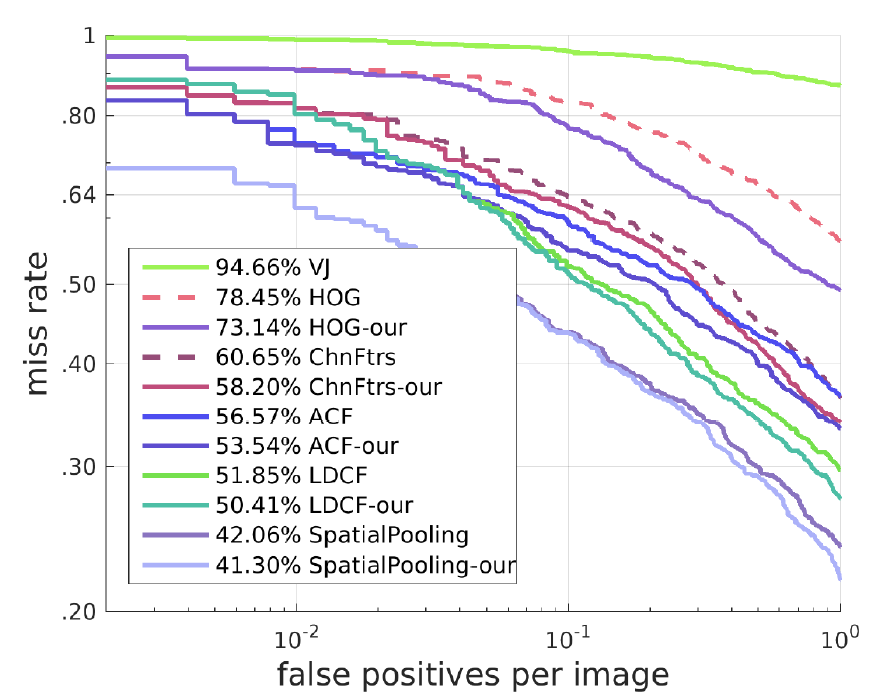
Figure 12. Results on the TUD-Brussels Pedestrian Dataset.